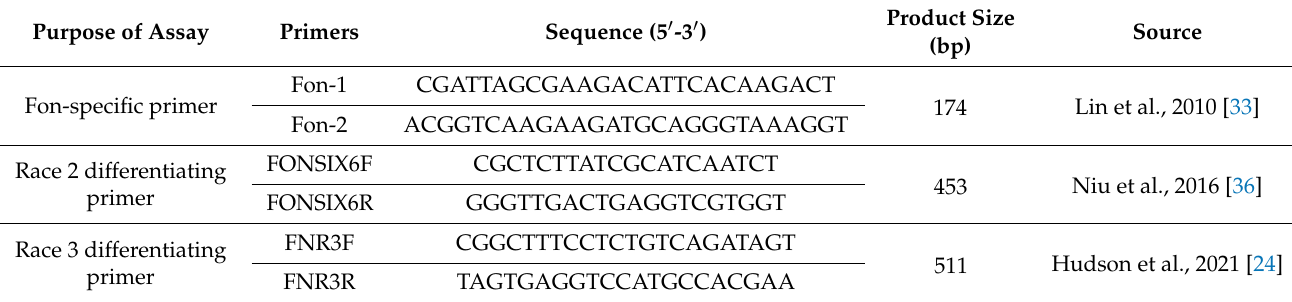
Table 2. Primers used for molecular detection and differentiation of Fon isolates.